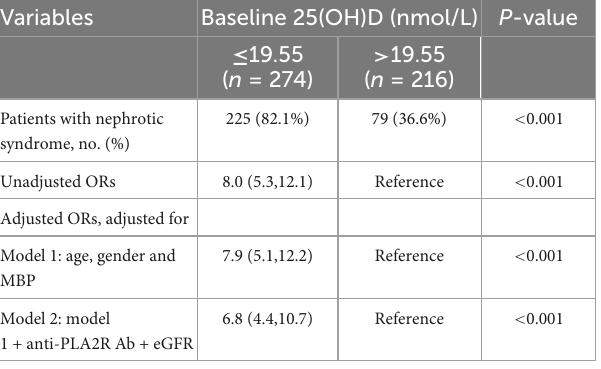
TABLE 3 Predicted performance of baseline 25(OH)D for seropositivity of the anti-PLA2R Ab in patients with PMN. Variables